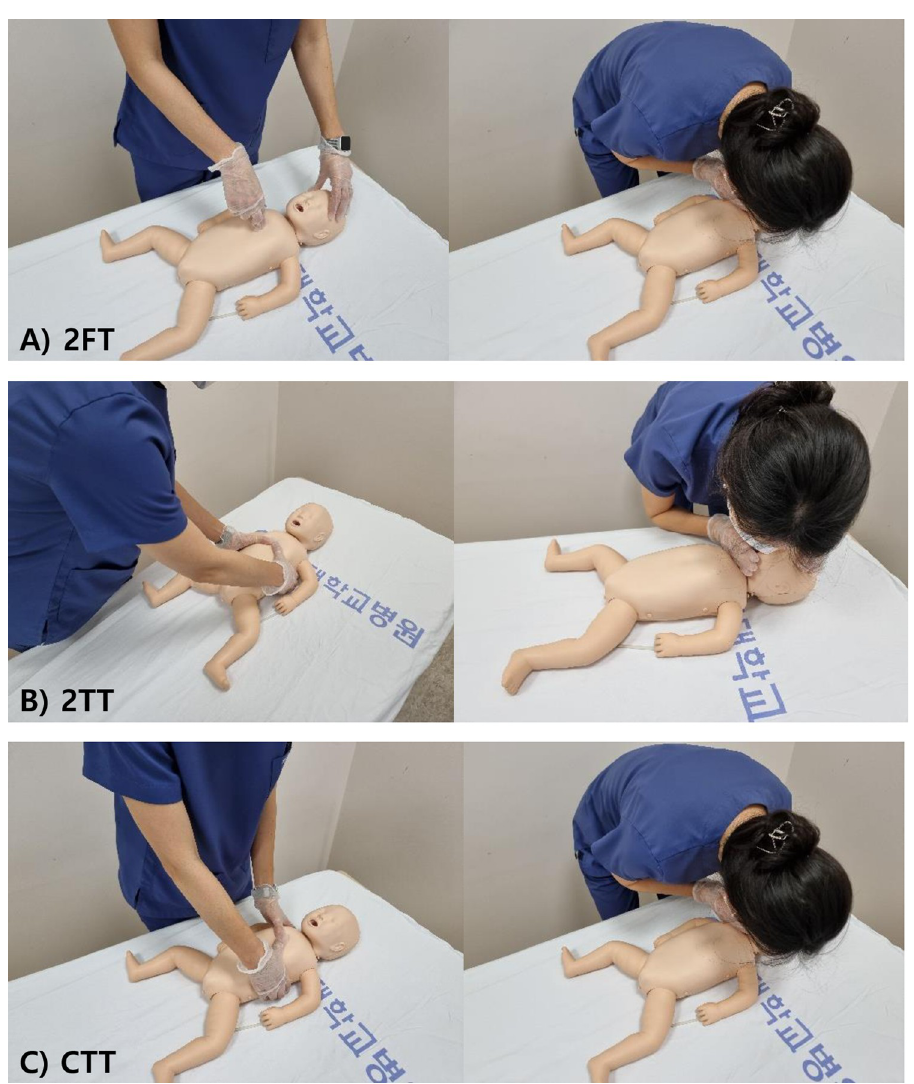
Fig 2. A rescuer’s location performing each chest compression technique. 2FT and CTT allow a rescuer to maintain the same position next to the patient’s chest and shoulder. With 2TT, the rescuer must perform chest compressions at the bottom of the patient. At the end of the compression cycle, the rescuer must move its position toward the patient’s head for ventilation. 2FT, two finger technique; 2TT, two thumb technique; CTT, cross-thumb technique.